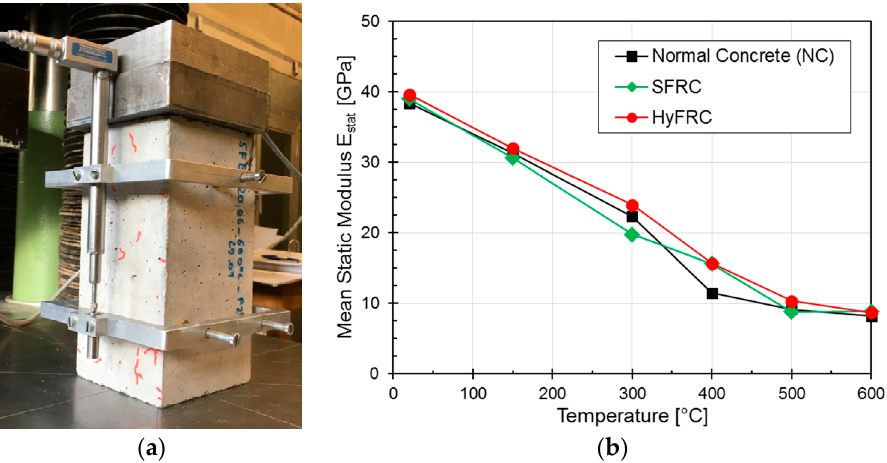
Figure 12. ( a ) Typical test setup and ( b ) variation of static modulus of elasticity with elevated temperature for different types of concrete.